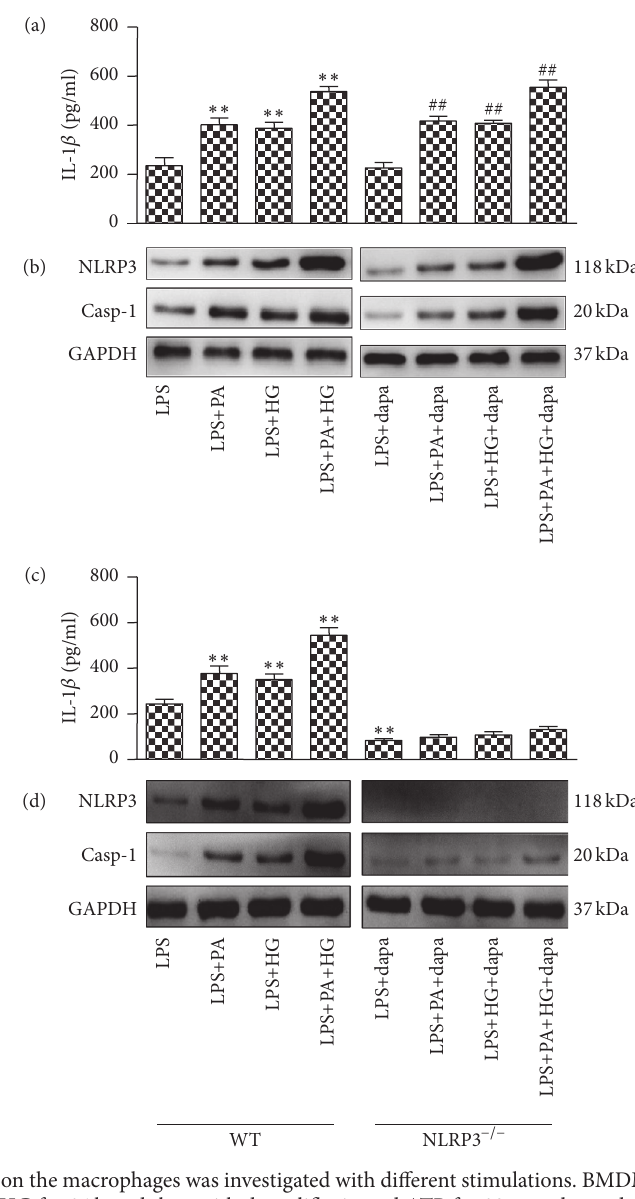
Figure 6: Effect of dapagliflozin on the macrophages was investigated with different stimulations. BMDMs from WT were treated with LPS, LPS+PA, LPS+HG, or LPS+PA+HG for 24 h and then with dapagliflozin and ATP for 30 m and tested the level of IL-1 𝛽 in the supernatant (a). Collecting the cell lysates and testing the expression of NLRP3 and caspase-1 with Western blot. Data show mean ± SD; 𝑛 = 3 . ∗ 𝑝 < 0.05 ; ∗∗ 𝑝 < 0.01 versus LPS. ## 𝑝 < 0.01 versus LPS+dapa (b). The WT and NLRP3 −/− mice macrophages were isolated, cultured, and stimulated with LPS, LPS+PA, LPS+HG, or LPS+PA+HG for 24 h and then assayed the IL-1 𝛽 in supernatant (c) and detected the expression of NLRP3 and caspase-1 in cell lysates with Western blot. Data show mean ± SD; 𝑛 = 3 . ∗ 𝑝 < 0.05 ; ∗∗ 𝑝 < 0.01 versus WT+LPS